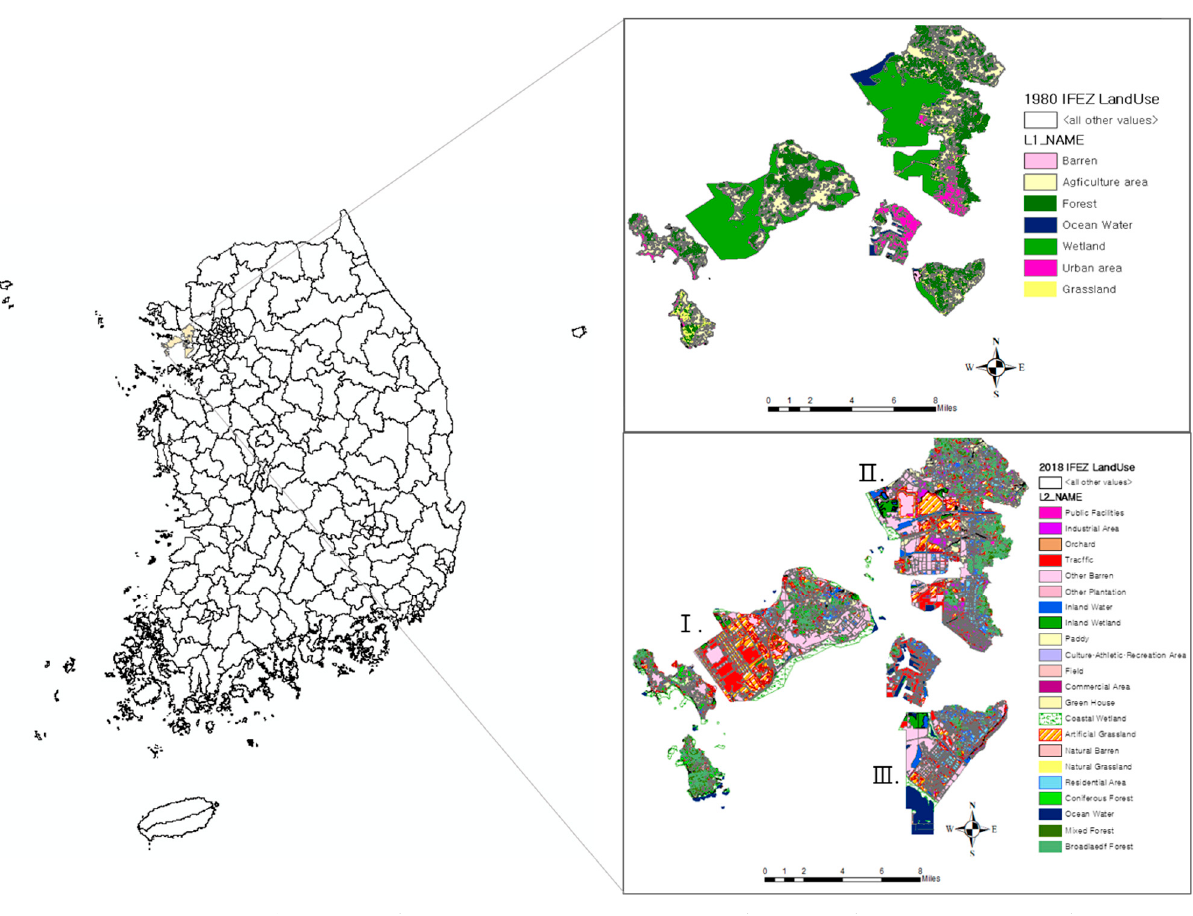
Figure 1. Study area. Ⅰ : Yeoungjong International City, Ⅱ : Cheongna International City, Ⅲ : Songdo International City.